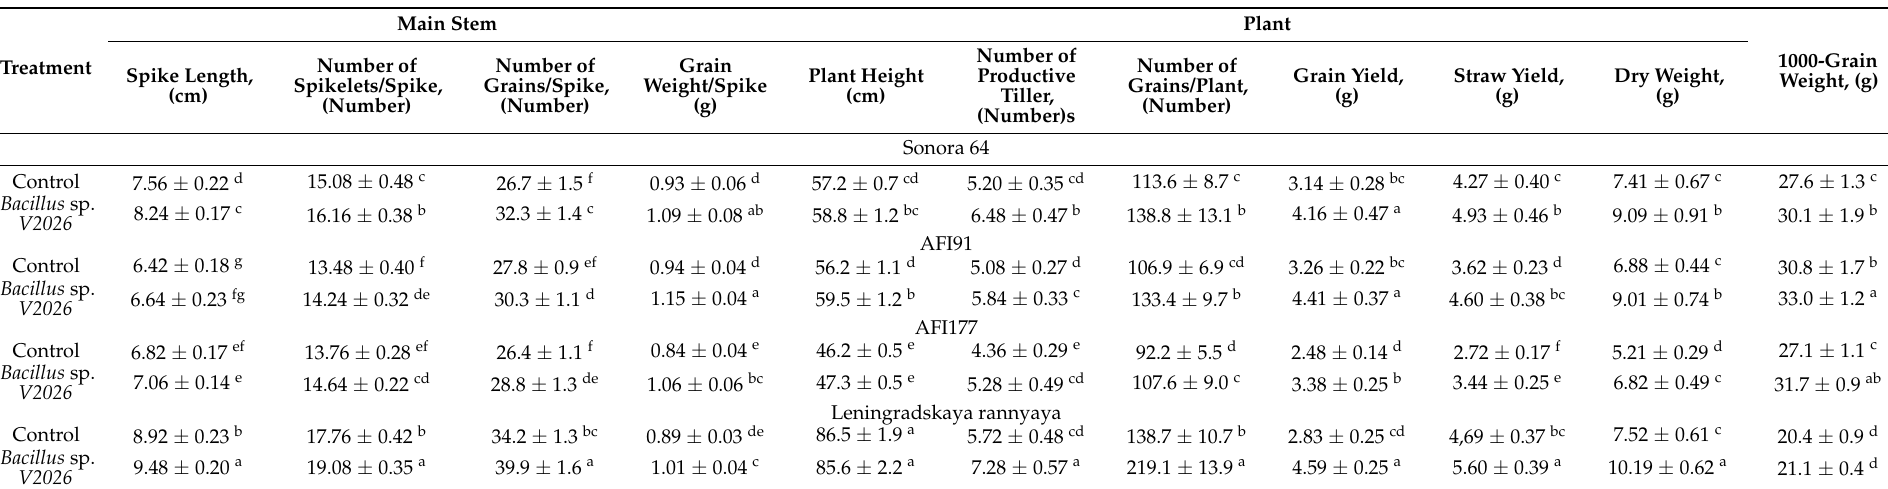
Table 1. Effect of inoculation with Bacillus sp. V2026 on yield attributes of early-maturing spring wheat.